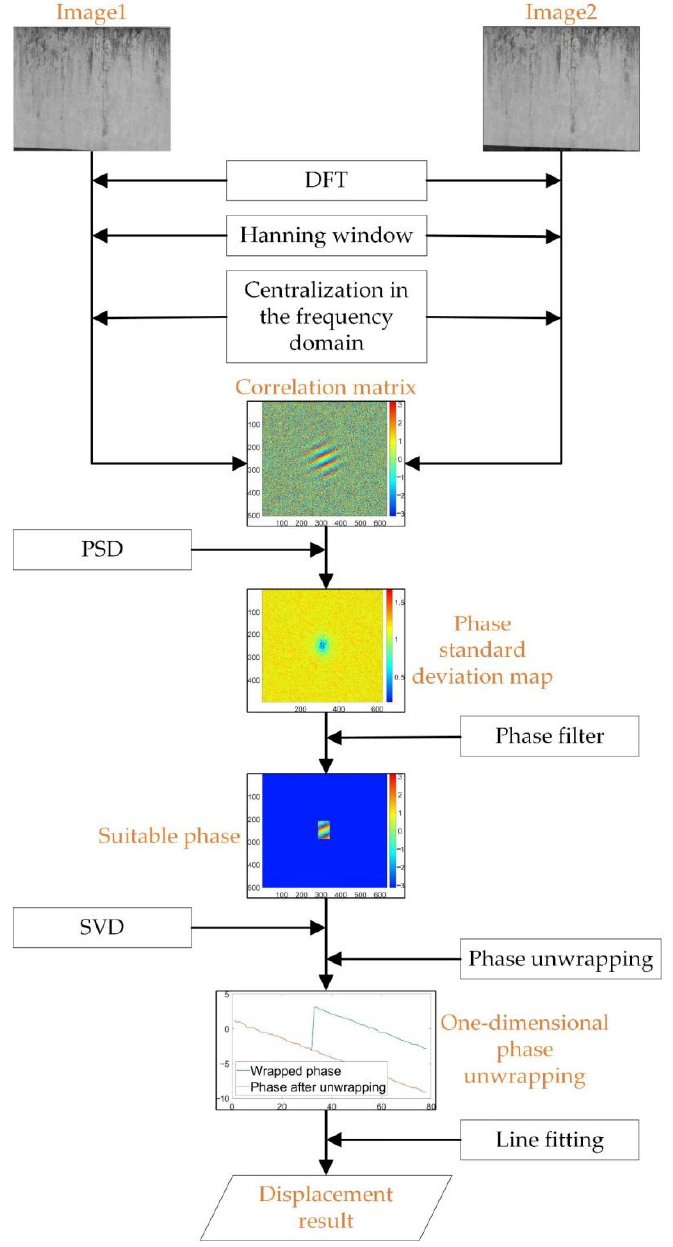
Figure 1. The workflow of the proposed method.